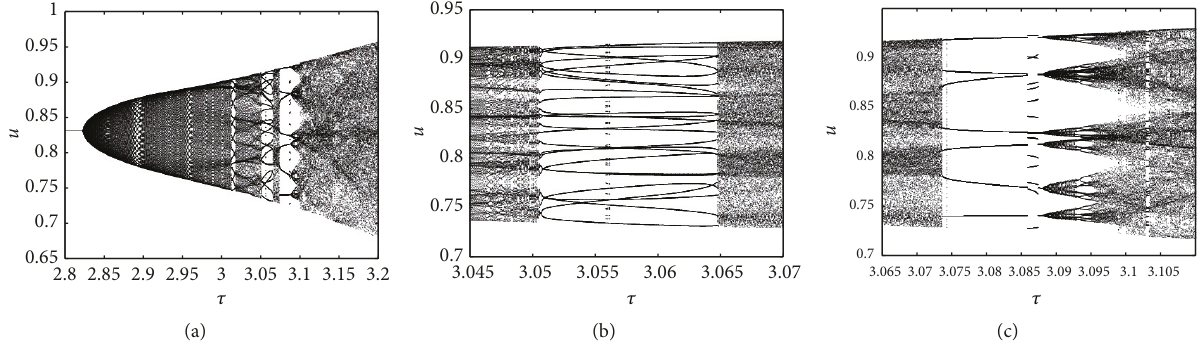
Figure 4: (a) Neimark-Sacker bifurcation diagram of the discrete predator-prey system corresponding to variation of 𝜏 ranging in [2.8,3.2] . 𝑎 = 0.1 , 𝑏 = 1.5 , 𝑐 = 0.5 , 𝑑 = 3.5 , and 𝑒 = 0.05 . (b) and (c) Local amplifications of (a) in [3.045,3.07] and [3.065,3.11] showing the detail of periodic